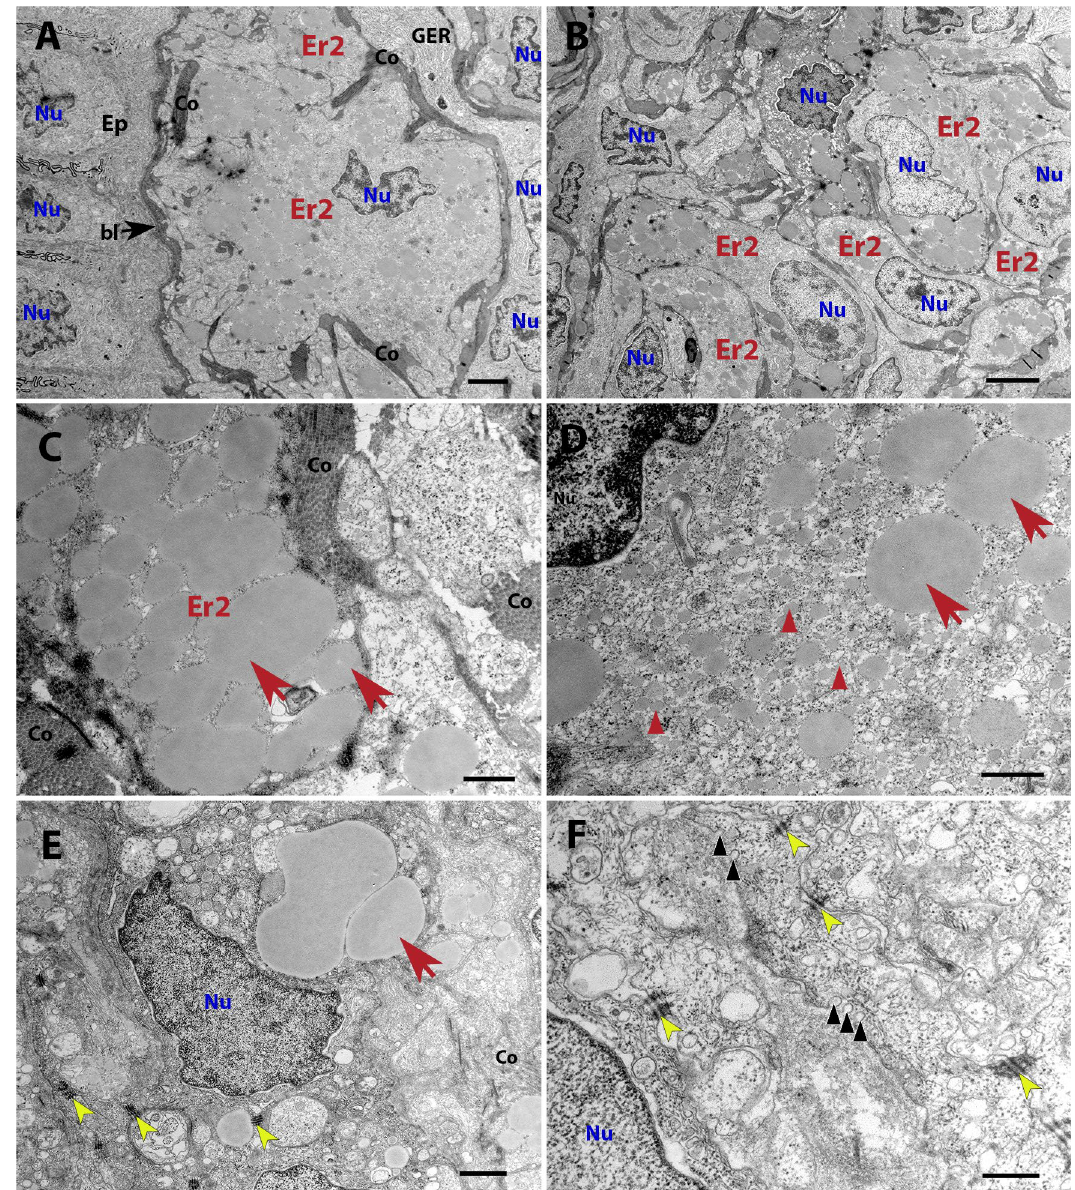
Figure 2. TEM images showing type 2 erythrophores from red spots. ( A ) A low magnification image of the area between the dermis and epidermis (on the left). ( B ) Type 2 erythrophores are the only pigment cells present in this skin area. ( C – E ) Ultrastructure of type 2 erythrophores, including erythrosomes (red arrows), carotenoid vesicles (red arrowheads). ( F ) Fibroblasts or fibroblast-like cells communicate with the extracellular space via prominent caveolae (black arrowheads) and are well connected with each other as well with type 2 erythrophores via desmosomes (yellow arrowheads),. bl basal lamina, Co collagen fibres, Ep epidermis, Er2 type 2 erythrophore, GER granular endoplasmic reticulum, Nu nucleus. Scale bars: 2 μm ( A ); 4 μm ( B ); 600 nm ( C , D ); 1 μm ( E ); 400 nm ( F